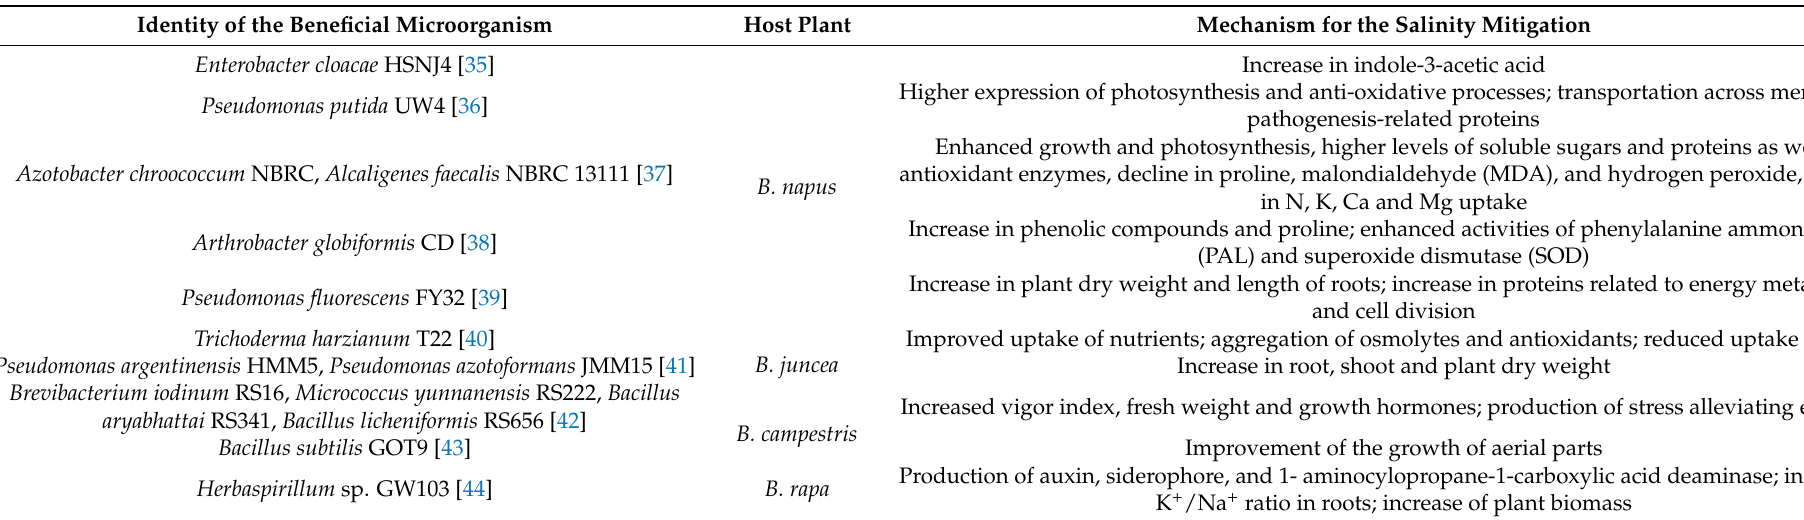
Table 1. Beneficial microorganisms in mitigating salt stress and its mechanism of action in Brassica